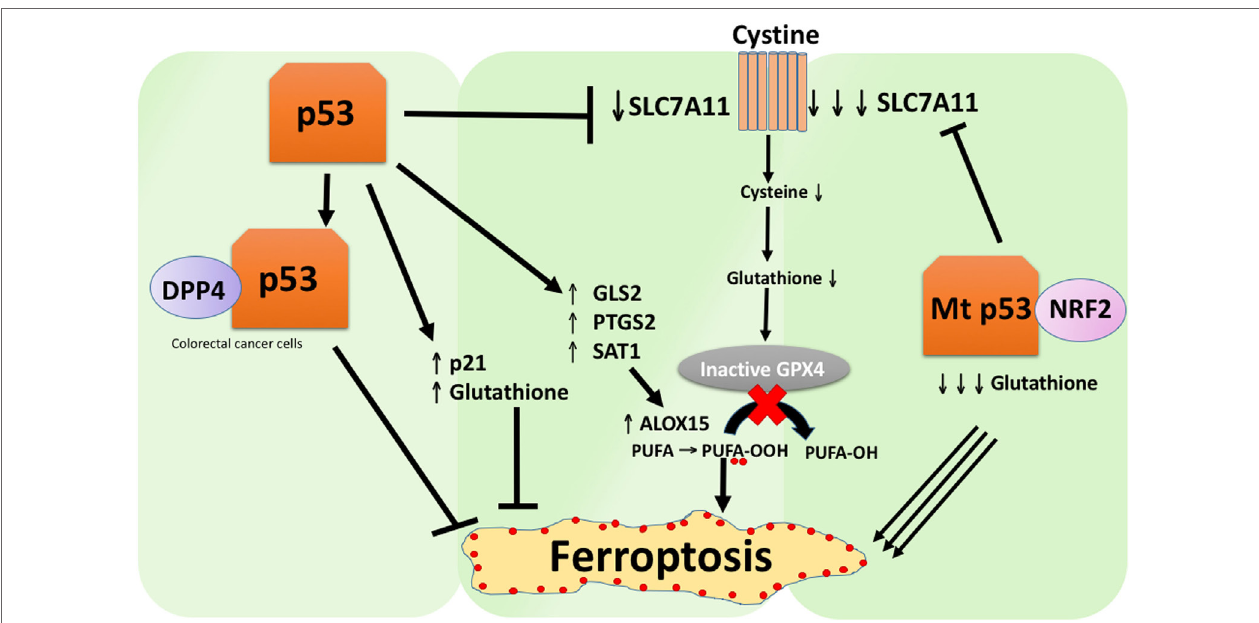
FigURe 2 | The various roles of p53 in ferroptosis. Inhibition of glutathione peroxidase 4 (GPX4), the key enzyme that catalyzes the conversion of polyunsaturated fatty acids (PUFAs) containing peroxides to alcohols, is the key driver of ferroptosis. Depending on the context, p53 can suppress ferroptosis (such as in colorectal cancer cells) or promote ferroptosis. Mutant p53 sensitizes cells to ferroptosis even more than wild-type